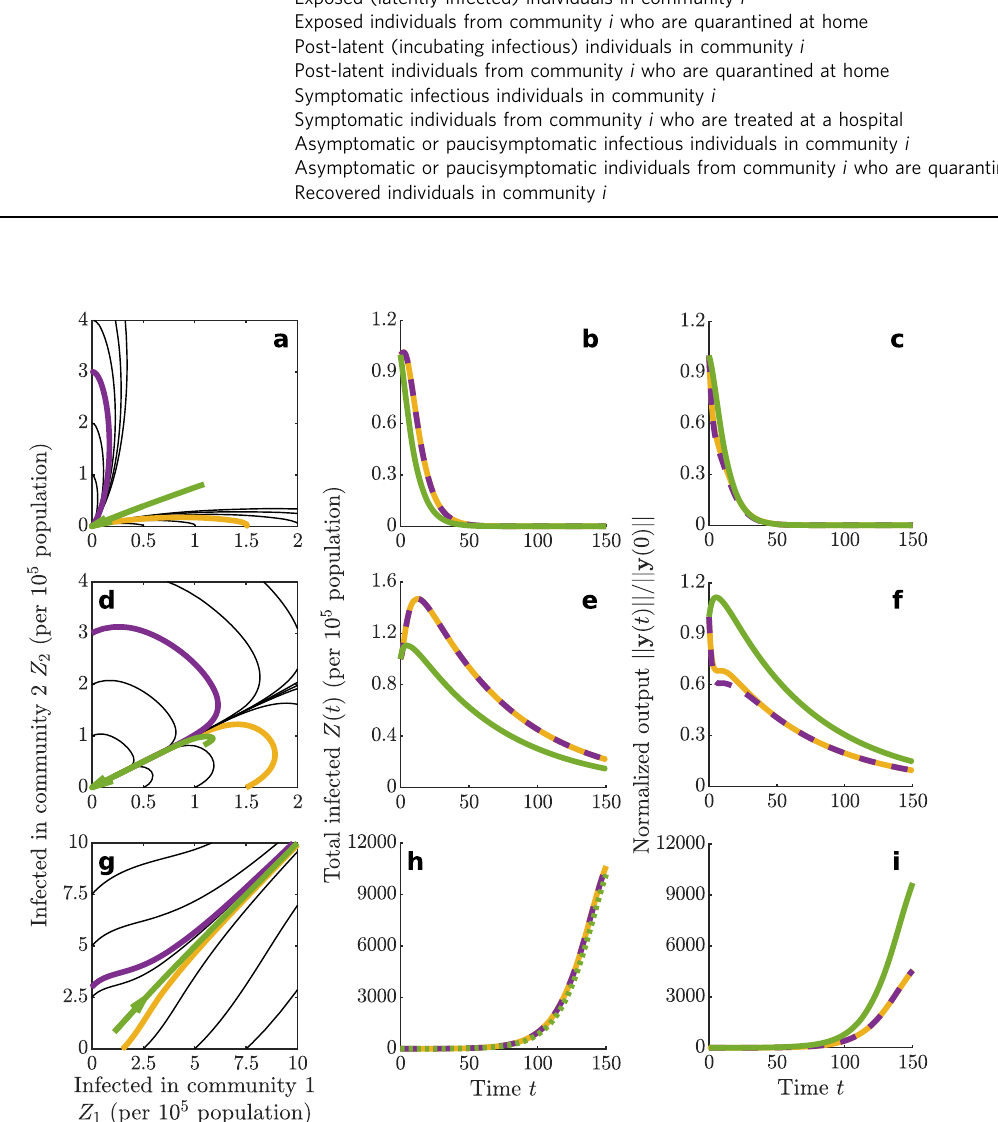
Fig. 1 A graphical illustration of the concept of epidemicity. Computational results for COVID-19 transmission in two human communities connected by mobility. a System trajectories projected onto the plane spanning the total number of infected people in each of the two communities ( Z i = E i + P i + I i + A i , i = 1, 2). Trajectories have been initialized with a few exposed individuals in either community (black, yellow, and purple curves), or with a mix of infected individuals in both communities (green, corresponding to the perturbation of the DFE with the fastest growth in the system output 25 ). For this parameter combination ( β P ¼ β P ¼ 1 : 2 ´ 10 (cid:2) 1 days − 1 ), all trajectories converge to the DFE ( R 0 < 1, e 0 < 0). b Temporal dynamics of the total number of infected 1 2 people in the two communities ( Z ( t ) = ∑ i [ E i ( t ) + P i ( t ) + I i ( t ) + A i ( t )]). Transmission chains fueled by the initial seeding of infected people decline rapidly over time. c Temporal dynamics of the system output, de fi ned as the Euclidean norm of the vector whose components correspond to the infection subsystem ( w X = 1, with X ∈ { E , P , I , A }). All trajectories are characterized by a monotonic decline in the system output. d – f As in ( a – c ), for a parameter combination ( β P ¼ β P ¼ 4 : 2 ´ 10 (cid:2) 1 days − 1 ) resulting in R 0 < 1 and e 0 > 0. In this case too, all trajectories converge to the DFE ( d ), but disease prevalence 1 2 exhibits a peak, later declining slowly over time ( e ). Also, for suitable initial conditions, a transitory increase of the system output following a pulse perturbation is possible ( f ). g – i As in ( a – c ), for a parameter combination ( β P ¼ β P ¼ 7 : 0 ´ 10 (cid:2) 1 days − 1 ) resulting in R 0 > 1 and e 0 > 0. In this case, 1 2 trajectories exponentially diverge from the DFE ( g ), and a large outbreak is observed in both disease prevalence ( h ) and the system output ( i ). In these examples, the population size of the fi rst community ( N 1 = 10 6 ) is twice as large as the size of the second ( N 2 = 5 × 10 5 ), and the people of the fi rst community are less mobile than those of the second ( M S ; E ; P ; A ¼ 1 = 10, M S ; E ; P ; A ¼ 2 = 3; symptomatic individuals are assumed not to move from either 12 21 community, M I ¼ M I ¼ 0). See “ Methods ” for details and Table 2 for other 12 21